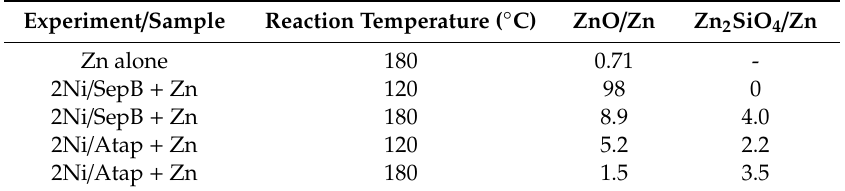
Table 4. Relative intensity of the most intense XRD peaks of Zn, ZnO and Zn 2 SiO 4 in used samples. Experiment / Sample